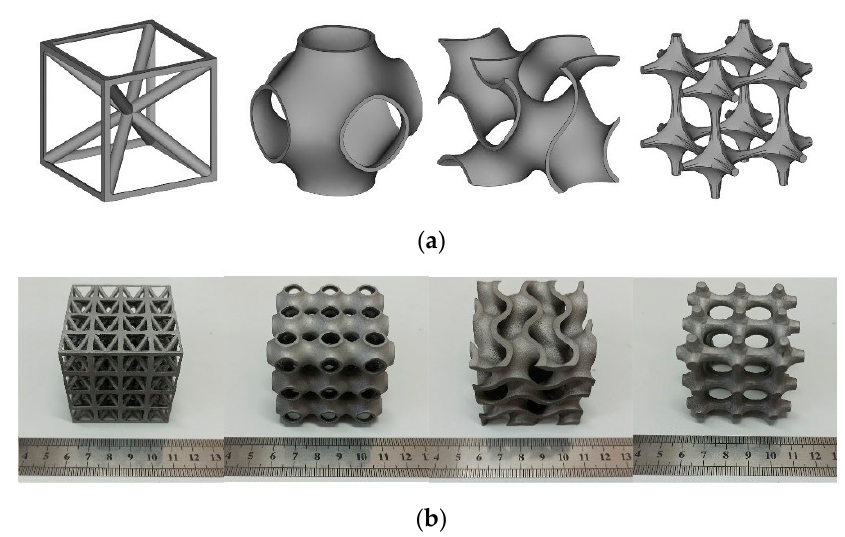
Figure 2. Structure diagram of each unit ( a ) and actual printed solid parts ( b ), from left to right, there are Bcc lattice, Primitive, Gyroid, and truss